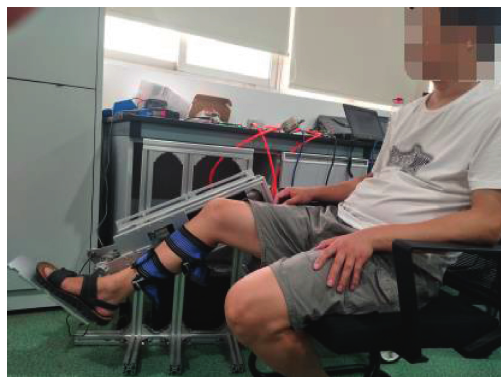
Figure 10: Experiment validations on a male with weight of 77kg and height of 176mm.